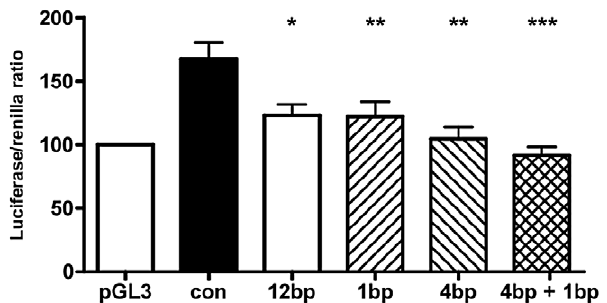
Figure 3. Indel polymorphisms decrease transcriptional effi- ciency. Luciferase assay of D Np63 promoters with various indel polymorphisms transfected into human embryonic kidney (HEK-293) cells. Normal Control sequence (con), 12 base pair deletion (12 bp; rs6148242), 1 base pair insertion (1 bp, rs5855273), 4 base pair insertion (4 bp, ss # 541028600). Data shown is the average of 8 experiments, each examined in triplicate. Data + / 2 SEM, * : p , 0.05, ** p , 0.01, *** : p , 0.001, compared to normal control, One-way